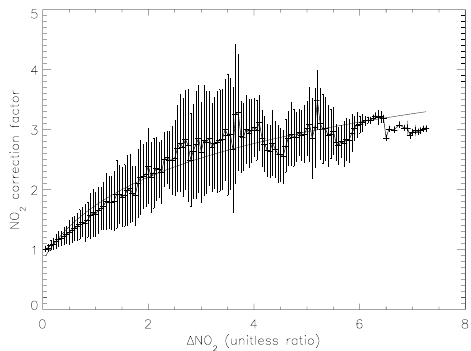
Figure 7. Relationship between the NO 2 correction factor and 1 NO 2 . Vertical bars represent the standard deviation of the NO 2 correction factor within each 1 NO 2 bin. The solid black line repre- sents the logarithmic fit to the